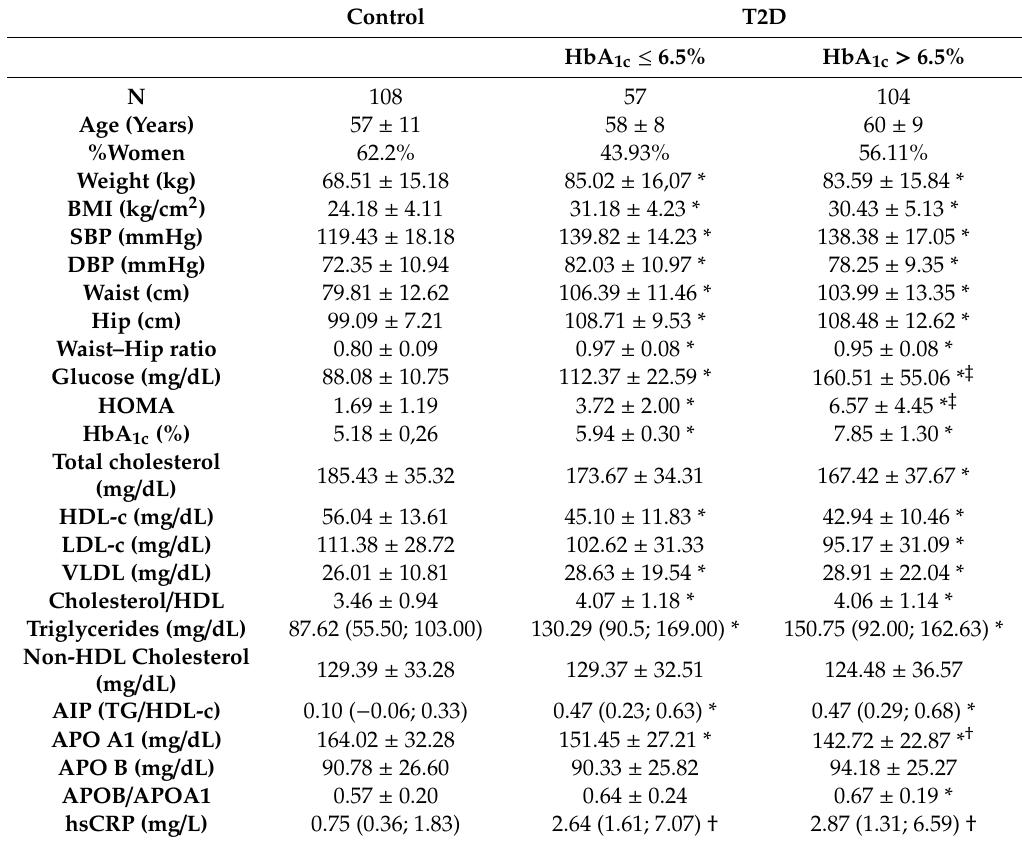
Table 1. Anthropometrical and biochemical